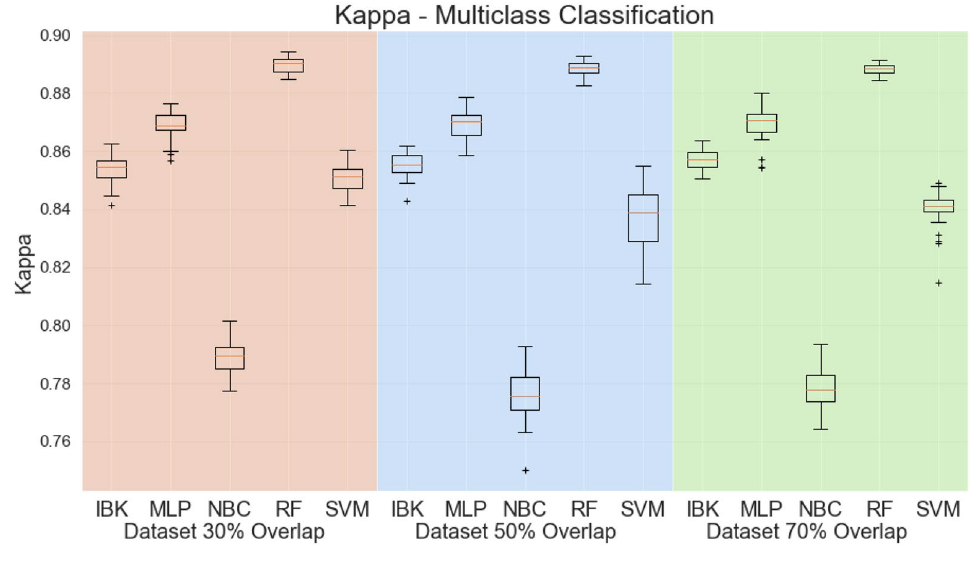
Figure 5. Kappa statistic for multiclass